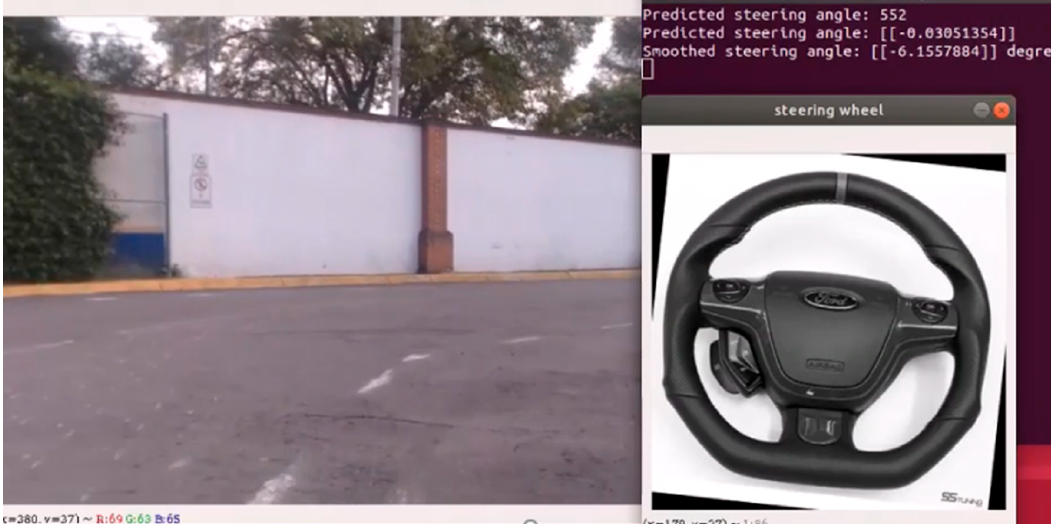
Figure 12. Stage 2 of a test, prediction of the model with unseen video.